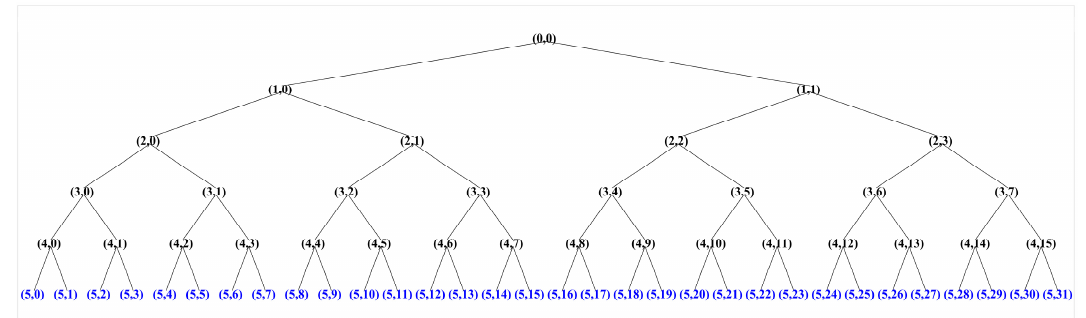
Figure 8. The wavelet packet tree of the vibration signal.